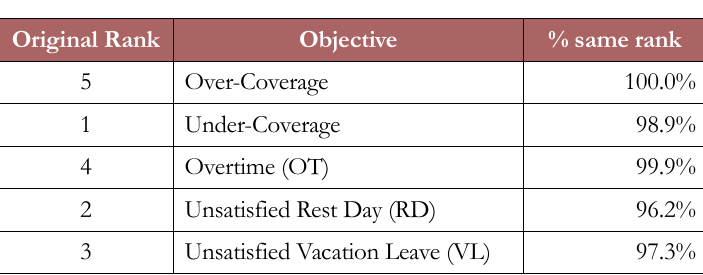
Table 11. Percentage of the time the objectives remain their original rank